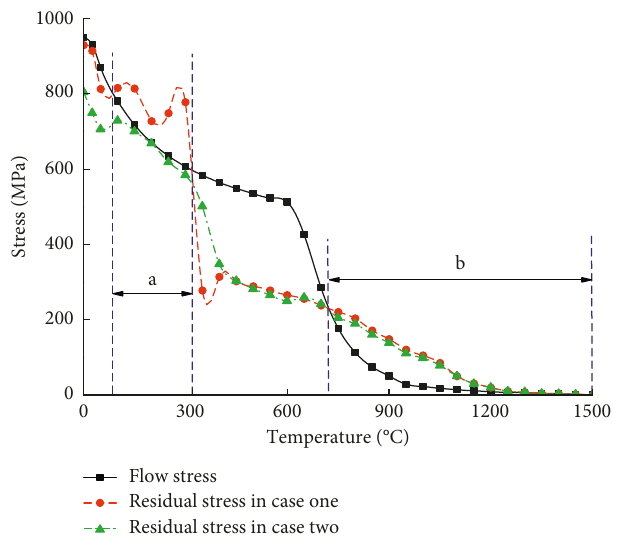
Figure 12: Comparison between the residual stress and the ma- terial flow